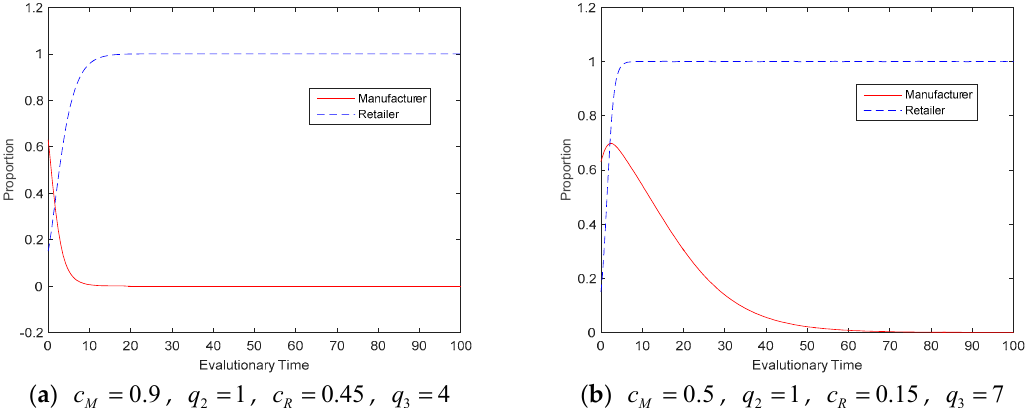
Appl. Sci. 2018 , 8 , x FOR PEER REVIEW Figure 4. The Evolution Process of Evolutionary Stable Strategy of Figure 4. The Evolution Process of Evolutionary Stable Strategy of E 3 ( 0,1 ) .